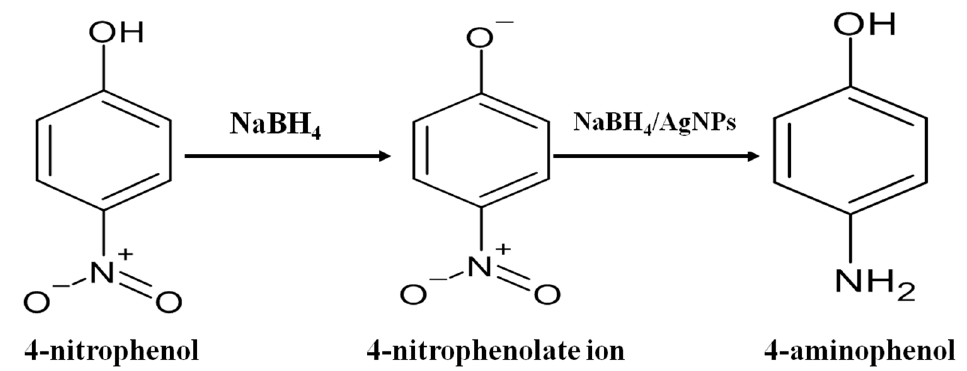
Figure 13. Schematic representation for reduction of 4-nitrophenol (4-NP) to 4-aminophenol (4-AP). To study the kinetics of the reaction, a plot of − ln (C/C 0 ) was plotted as a function of time and was displayed in Figure 14e. The C/C 0 values were measured from the reduction of λ max = 400 nm. The linear fit of the plot offered R-square values (coefficient of determination) 0.994 and 0.995, close to unity for a catalyst amount of 1 and 2 mL respectively. This supports the pseudo-first-order mechanism for the reduction of 4-NP.